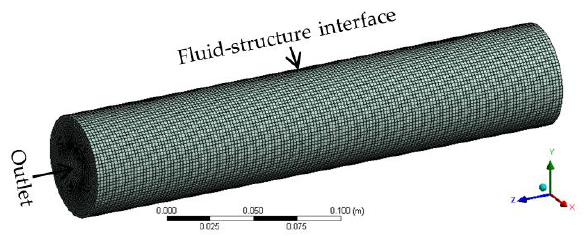
Figure 3. The finite element model of fluid domain. 184